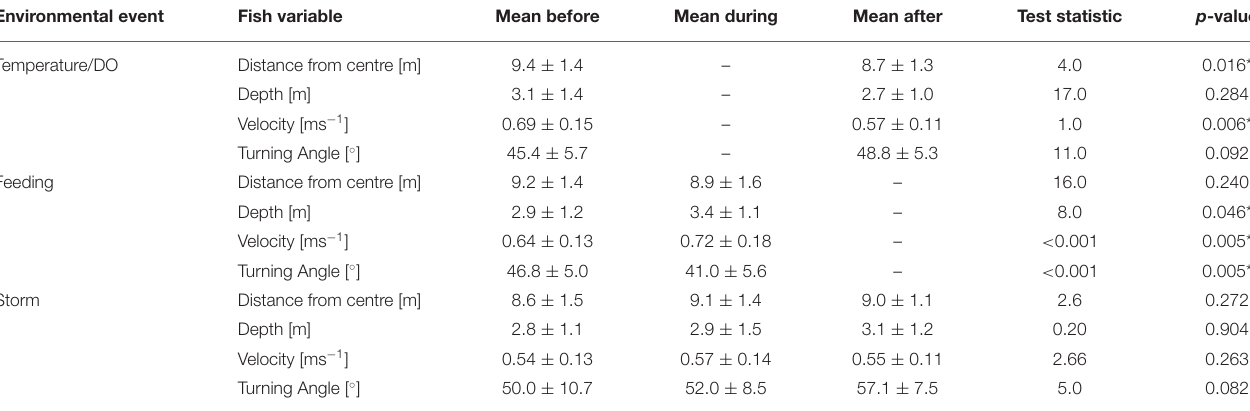
TABLE 1 | Mean values and standard deviation for each fish variable during environmental